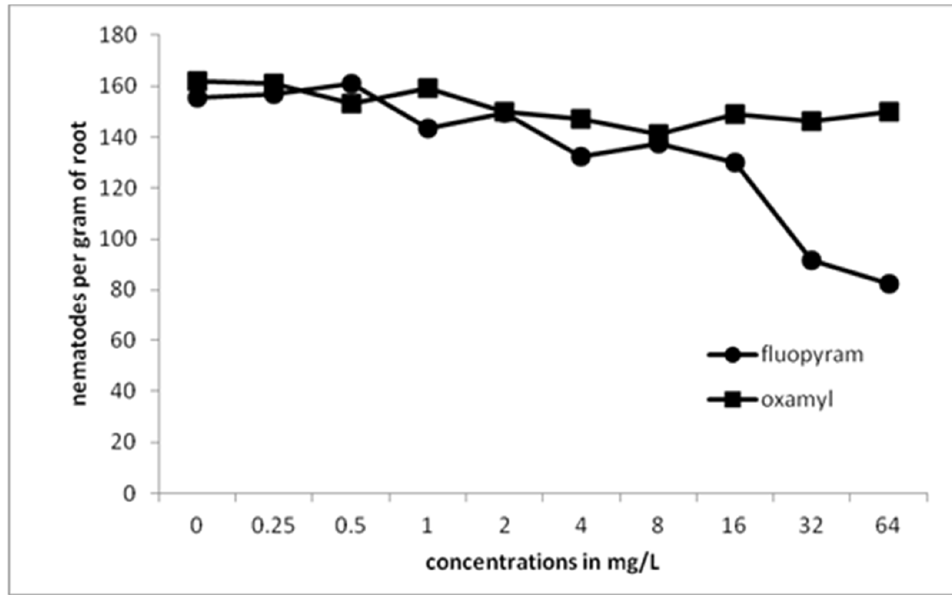
Figure 6. Numbers of all developmental stages of M. javanica per gram of root after transplanting tomato plants infected with 500 Meloidogyne javanica J2s in soil treated with fluopyram or oxamyl.